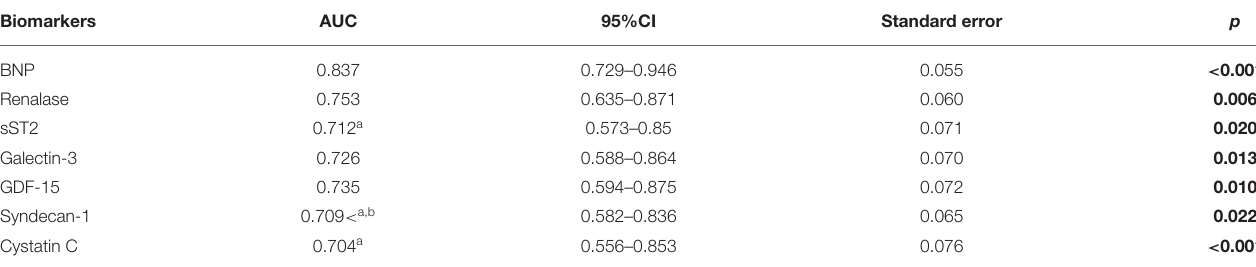
TABLE 4 | Areas under the ROC curve for prediction of ischemia in total heart failure group. Biomarkers